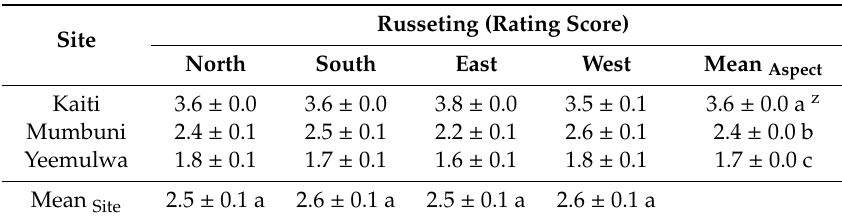
Table 5. E ff ect of geographical orientation (aspect) of ‘Apple’ mango on russeting. Fruits were sampled from north-, south-, east-, and west-facing sides of the canopy. The tree rows were aligned perpendicularly to the slope and N, S, E, and W positions. Russeting was quantified using a five-score rating scheme. Score 0: 0% of the fruit surface area russeted; score 1: 1–10% russeted area; score 2: 11–25% russeted area; score 3: 26–50% russeted area; and score 4: 51–100% russeted